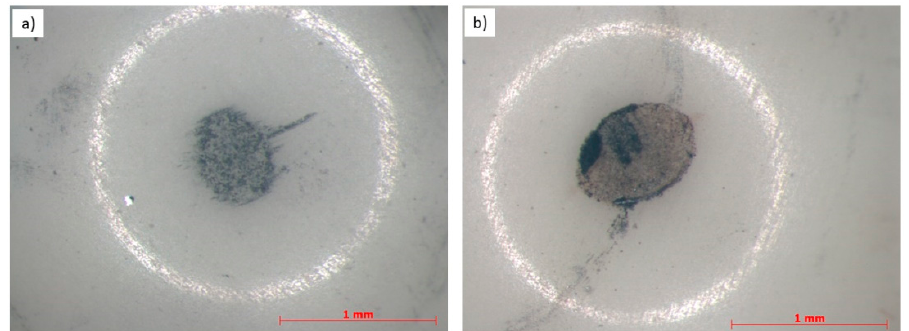
Figure 11. Comparison of Al 2 O 3 counter-body wear traces after testing against the ( a ) WC and ( b ) CrC sprayed